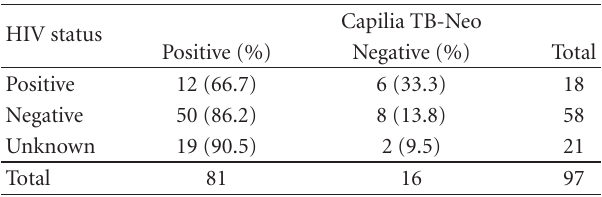
Table 1: Association of mycobacteria genus and HIV status of subjects.